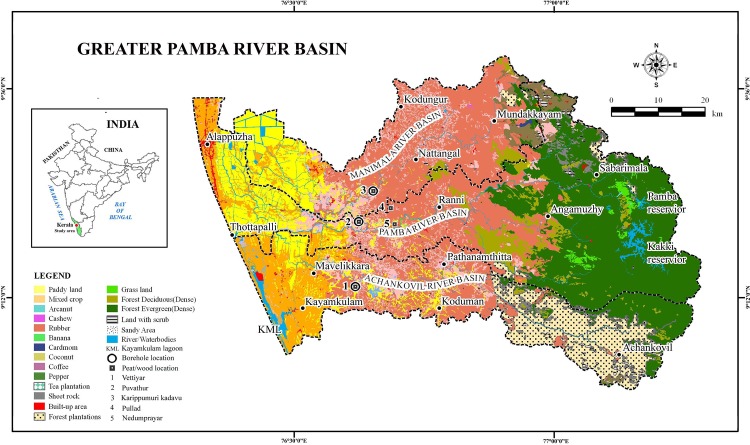
Land use / Land cover map of Greater Pamba River Basin (Achankovil, Pamba and Manimala rivers) showing locations of peat/wood deposits and borehole cores.